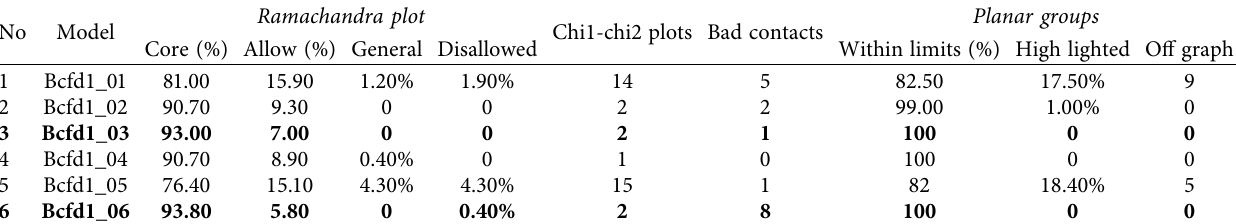
Table 2: Bcfd1 models evaluation using